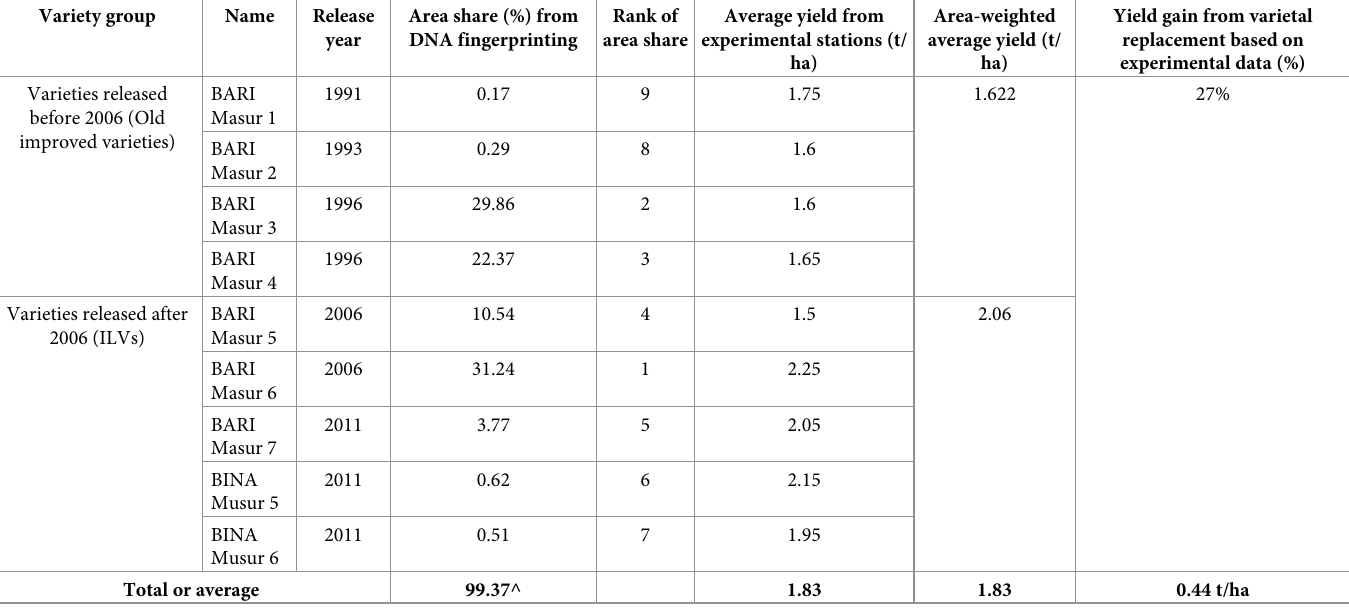
Table 5. Yield gains from improved lentil varieties (ILVs) based on data from experimental